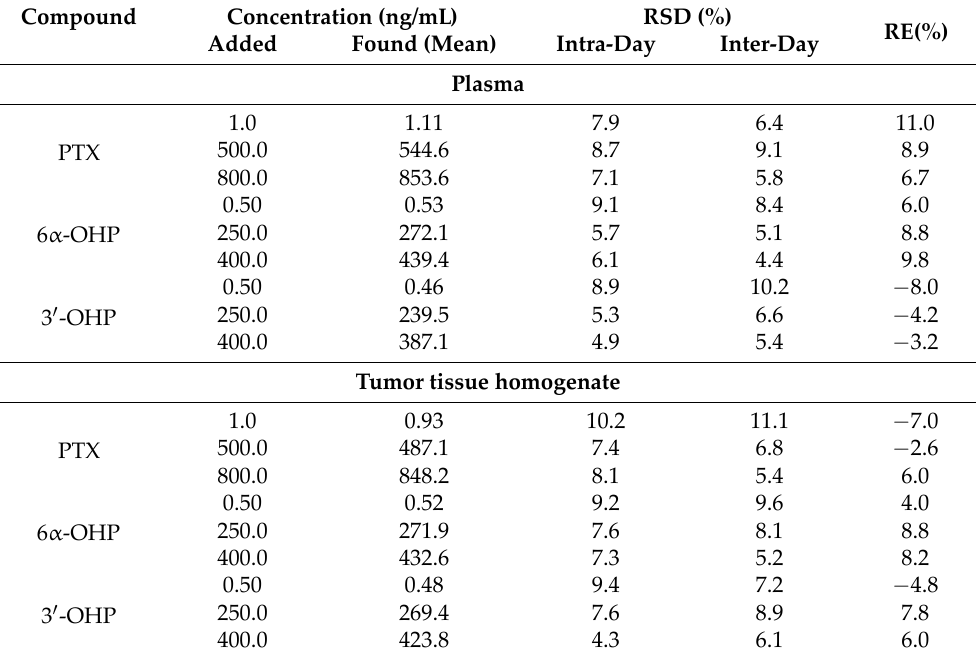
Table 3. Precision and accuracy of PTX, 6 α ‑OHP, and 3 homogenate (over three validation days, with six replicates at different concentration levels per day). Compound Concentration